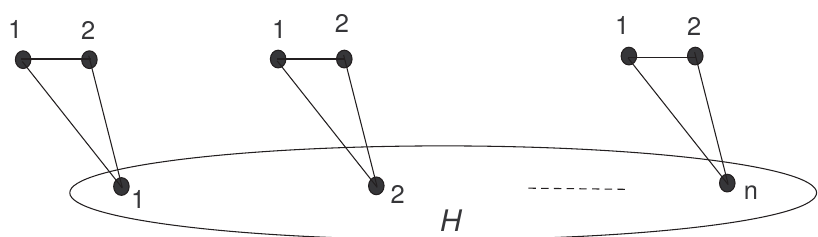
Figure 6. The bottleneck graph B of graph H